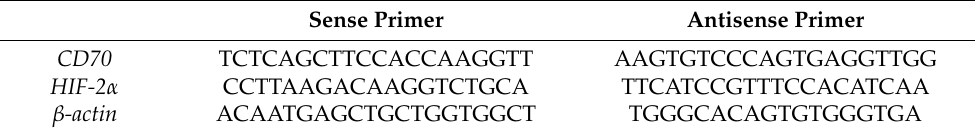
Table 2. Primers used for